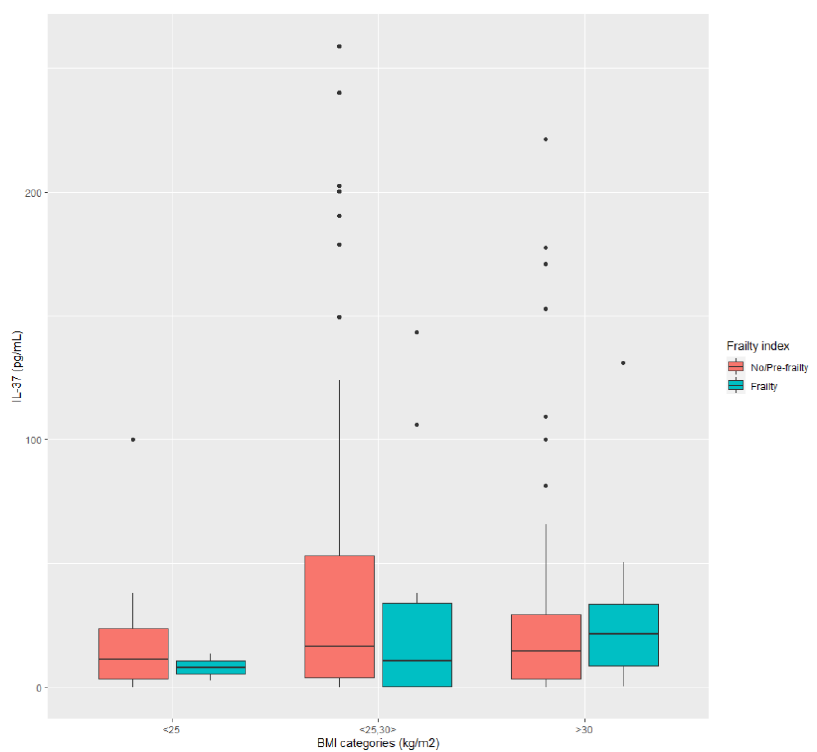
Figure 4. IL-37 according to frailty status (non frail + pre-frail/frail).